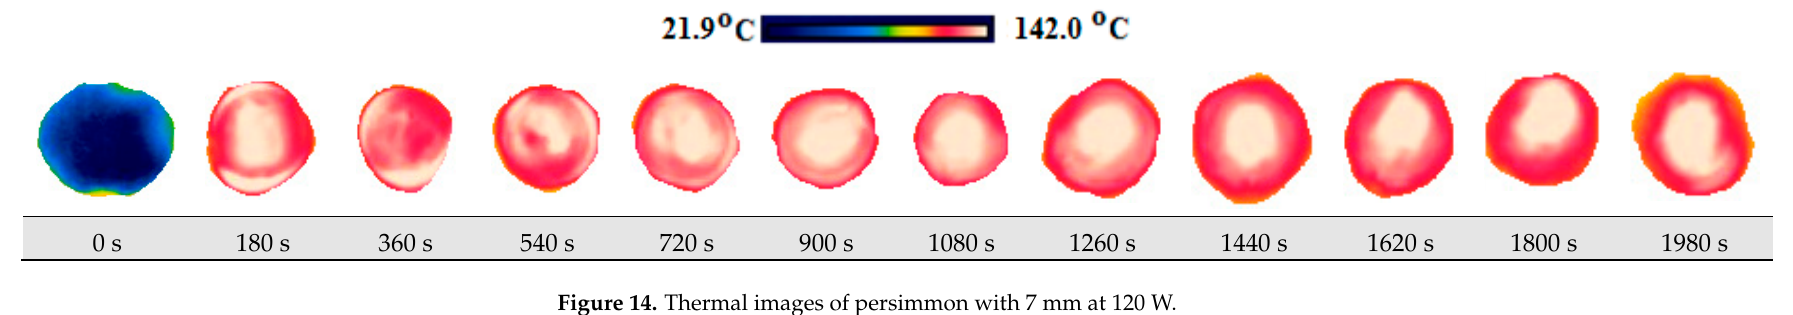
Figure 13. Thermal images of persimmon with 5 mm at 600 W.